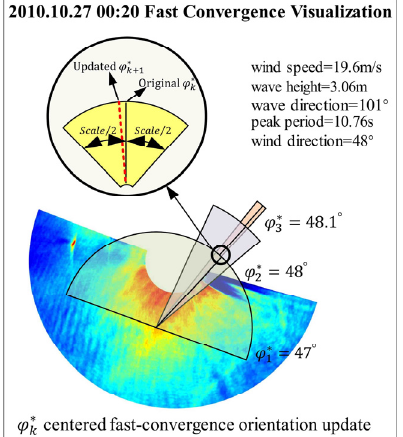
Figure 6. Fast-convergence visualization of radar image on 00:20 UTC+8 27 October 2010. (The sector part is the search area of each iteration and the circular part is the specific method of iterative